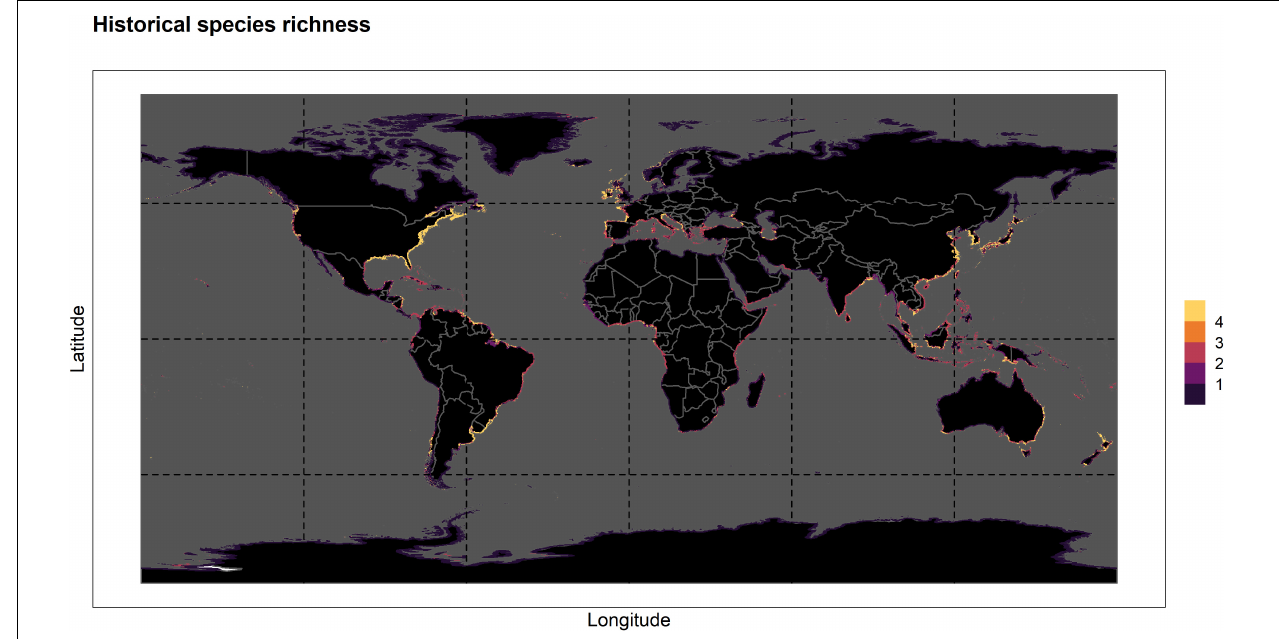
FIGURE 2 | Potential historical (1971–2000) worldwide richness distribution of Spartina spp. species (i.e., S. alterniflora , S. anglica , S. densiflora , S. maritima , and S. patens ) obtained from summing each species’ SDM-plotted historical presence and absence predictions.